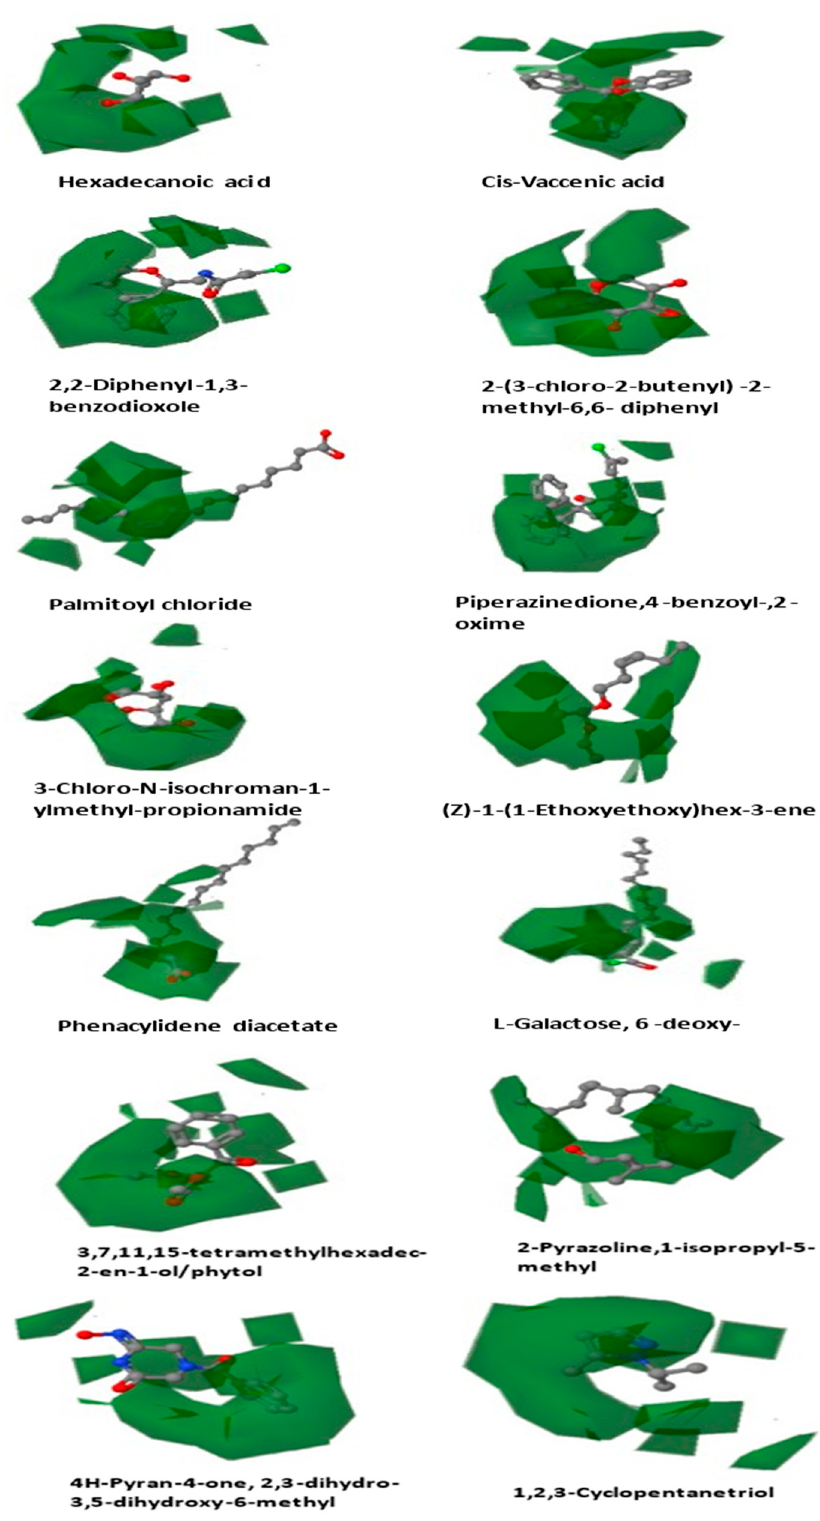
Figure 5. Contour maps of all ligands .